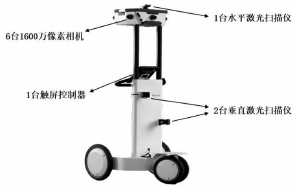
Figure 1. NavVis M3 Indoor scanning vehicle